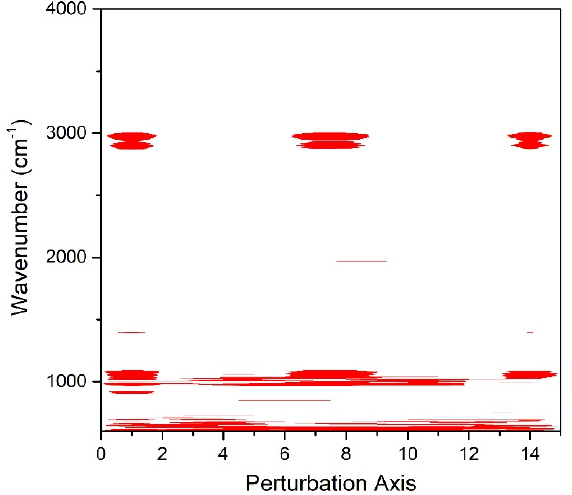
Figure 6. MW2D contour map for the visualization of the dynamic spectra changes.